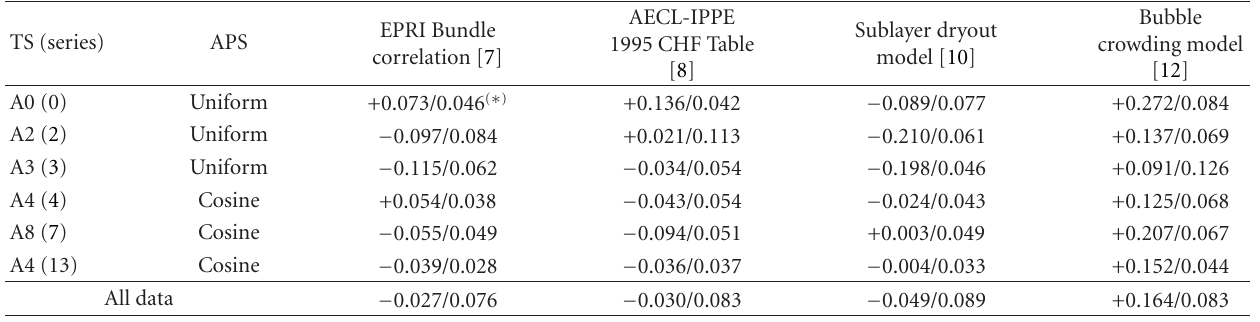
Table 6: P / M statistics for steady-state DNB benchmark